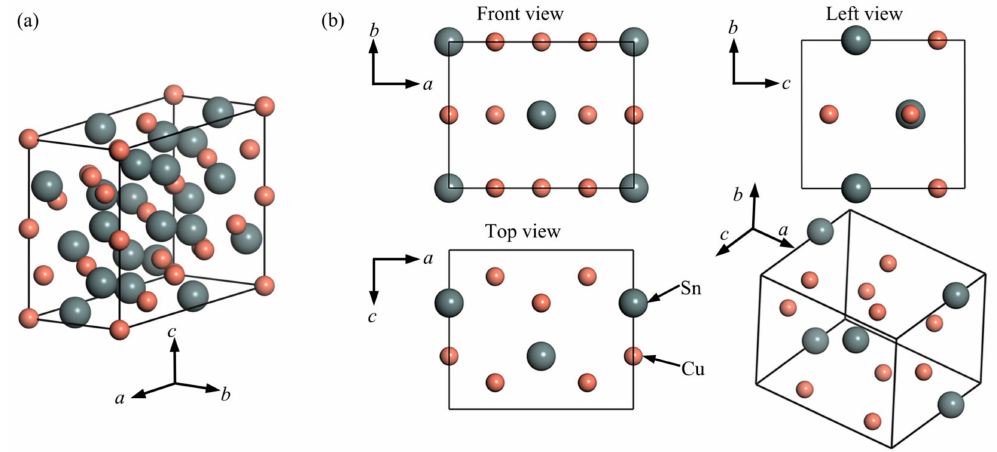
Figure 1. Crystal structures: ( a ) unit cell of monoclinic η (cid:48) -Cu 6 Sn 5 ; ( b ) three views of unit cell of orthorhombic Cu 3 Sn.